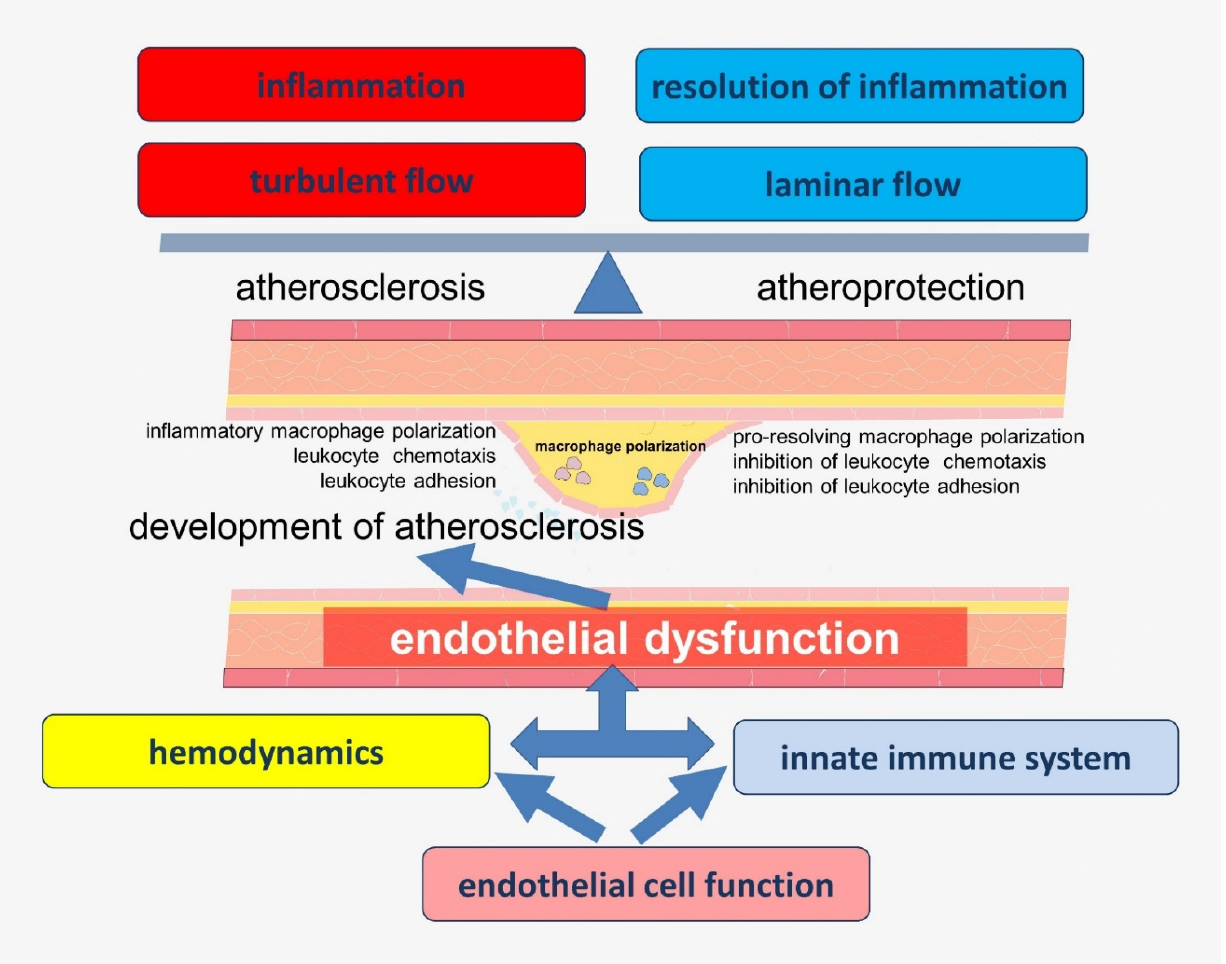
Figure 1. The significance of hemodynamic disturbances and inflammation in the development of atherosclerosis.